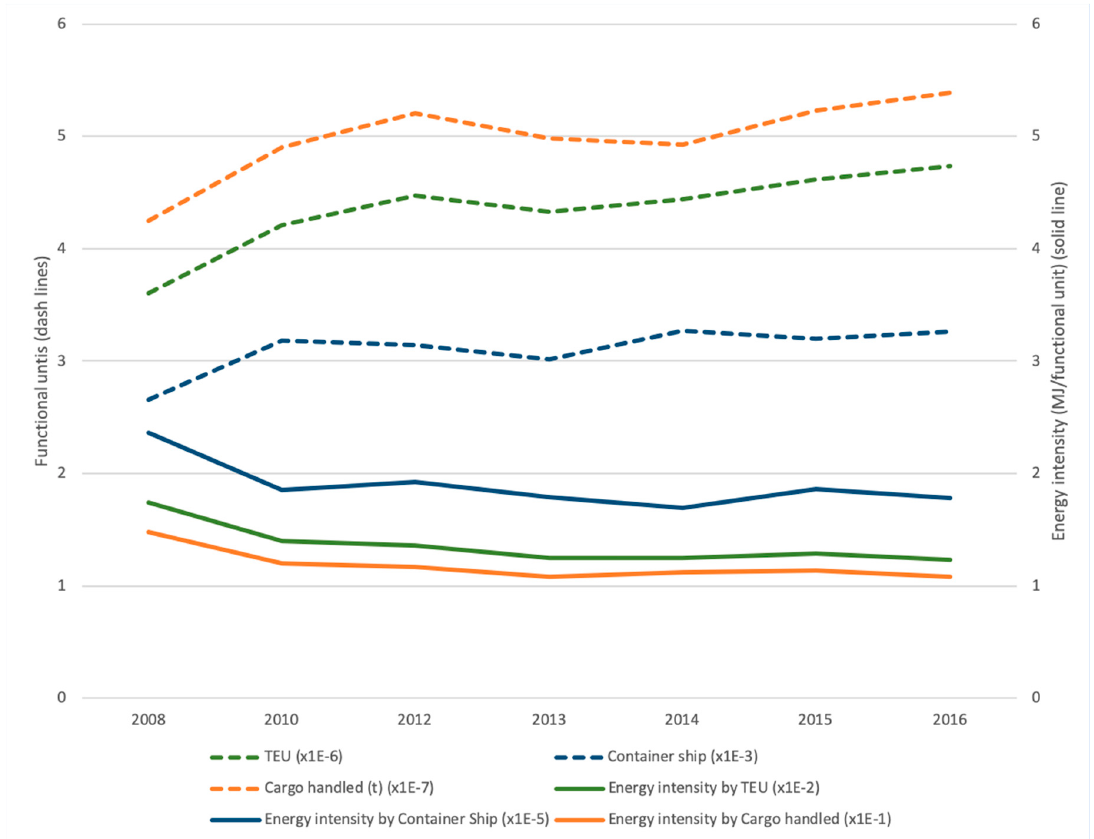
Energies 2020 , 13 , x FOR PEER REVIEW Figure 8. Energy intensity and functional units. Figure 8. Energy intensity and functional units.